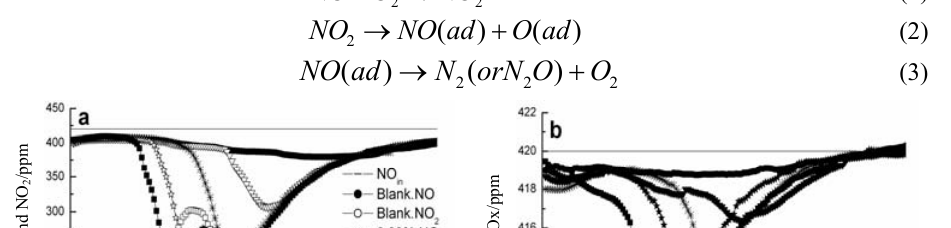
and NOx over Ir/ZSM-5 2